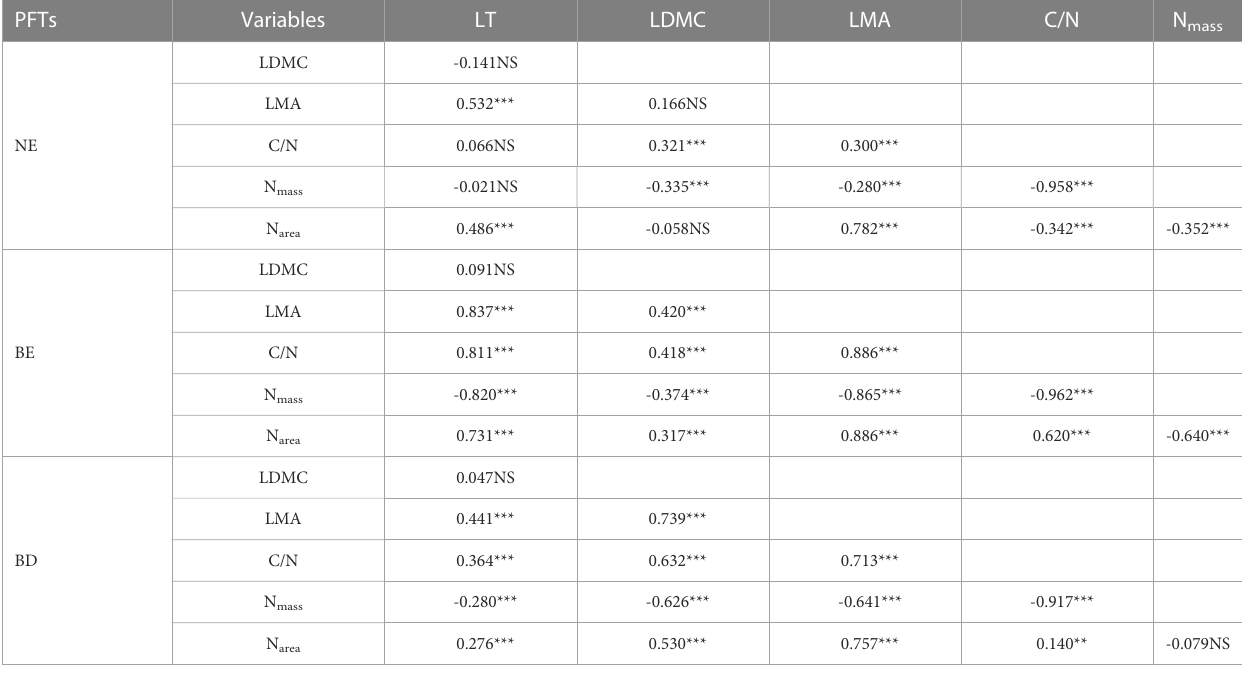
TABLE 2 The result of Pearson ’ s correlation among different leaf